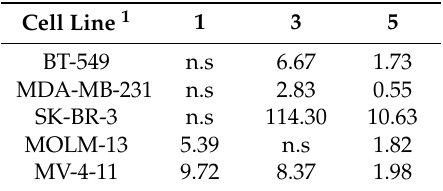
Table 1. Half maximal inhibitory concentration (IC 50 ) values of compound 1 vs. ferrocene analogues 3 and 5 in vitro (µM).